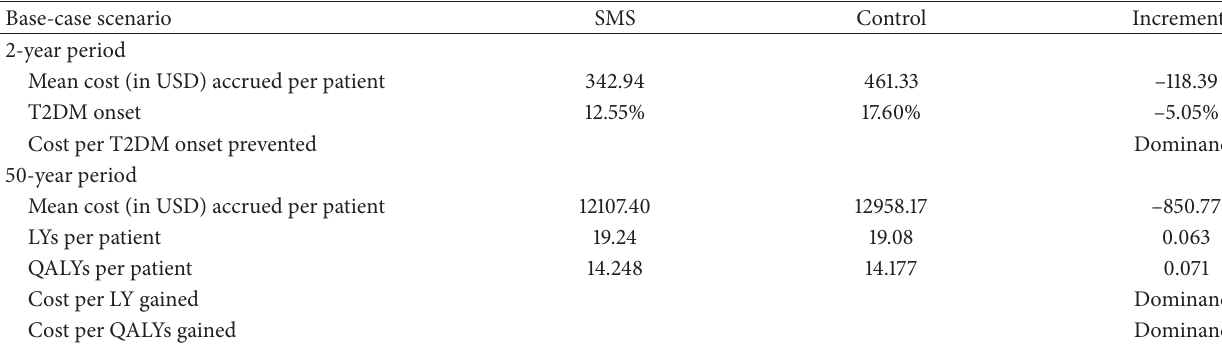
Table 3: Results of base-case